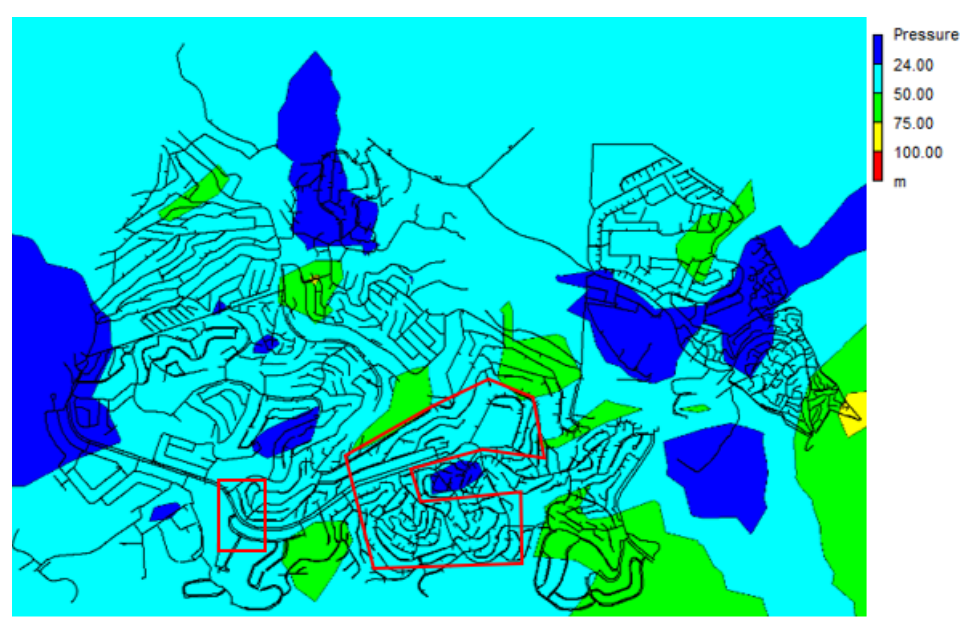
Figure 6. Pressure head reduction due to addition of PAT-2.